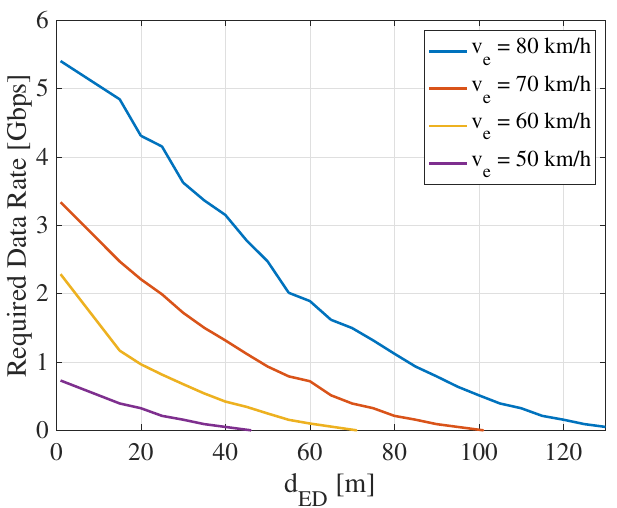
Figure 4. Required data rate of mmWave V2V relays ( d ED ∈ ( 0,130 ] m, v e ∈ [ 50,80 ]